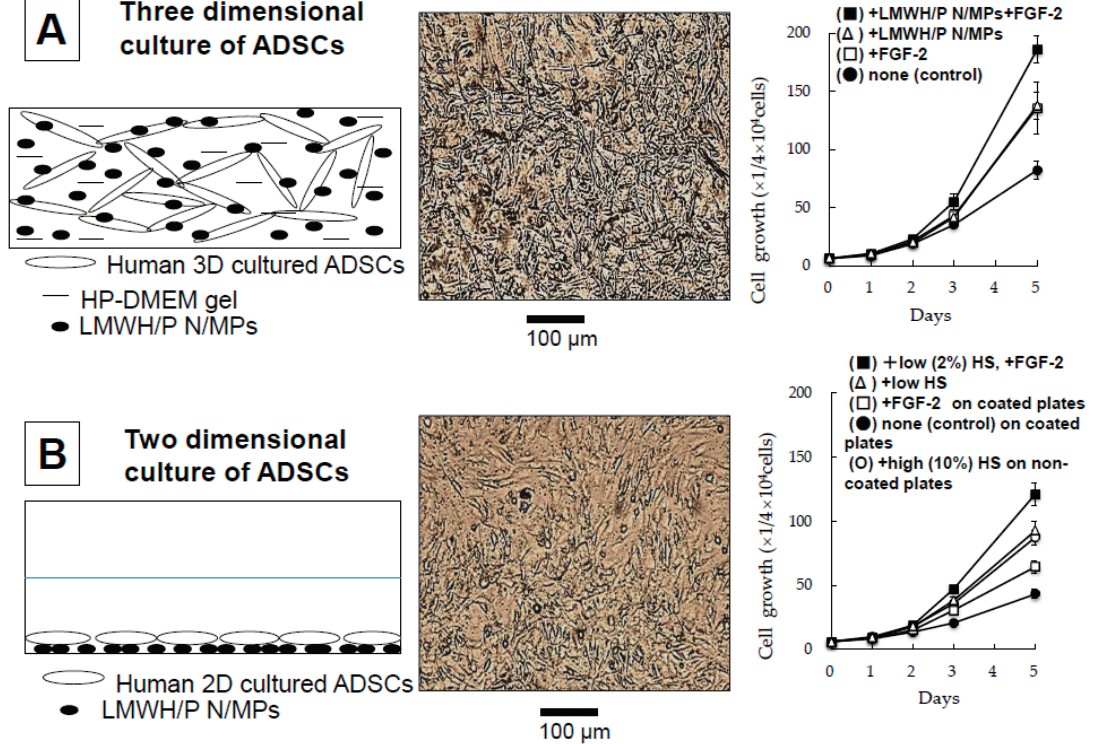
Figure 7. Three dimensional culture of ADSCs with HP-DMEM gel and LMWH/P NPs. ( A ) Three dimensional culture of ADSCs; ( B ) Two dimensional culture of ADSCs. 2.7. Transplantation of Inbred Rat Adipose-Derived Stromal Cells (IR-ADSCs) Using Plasma Gel with LMWH/P